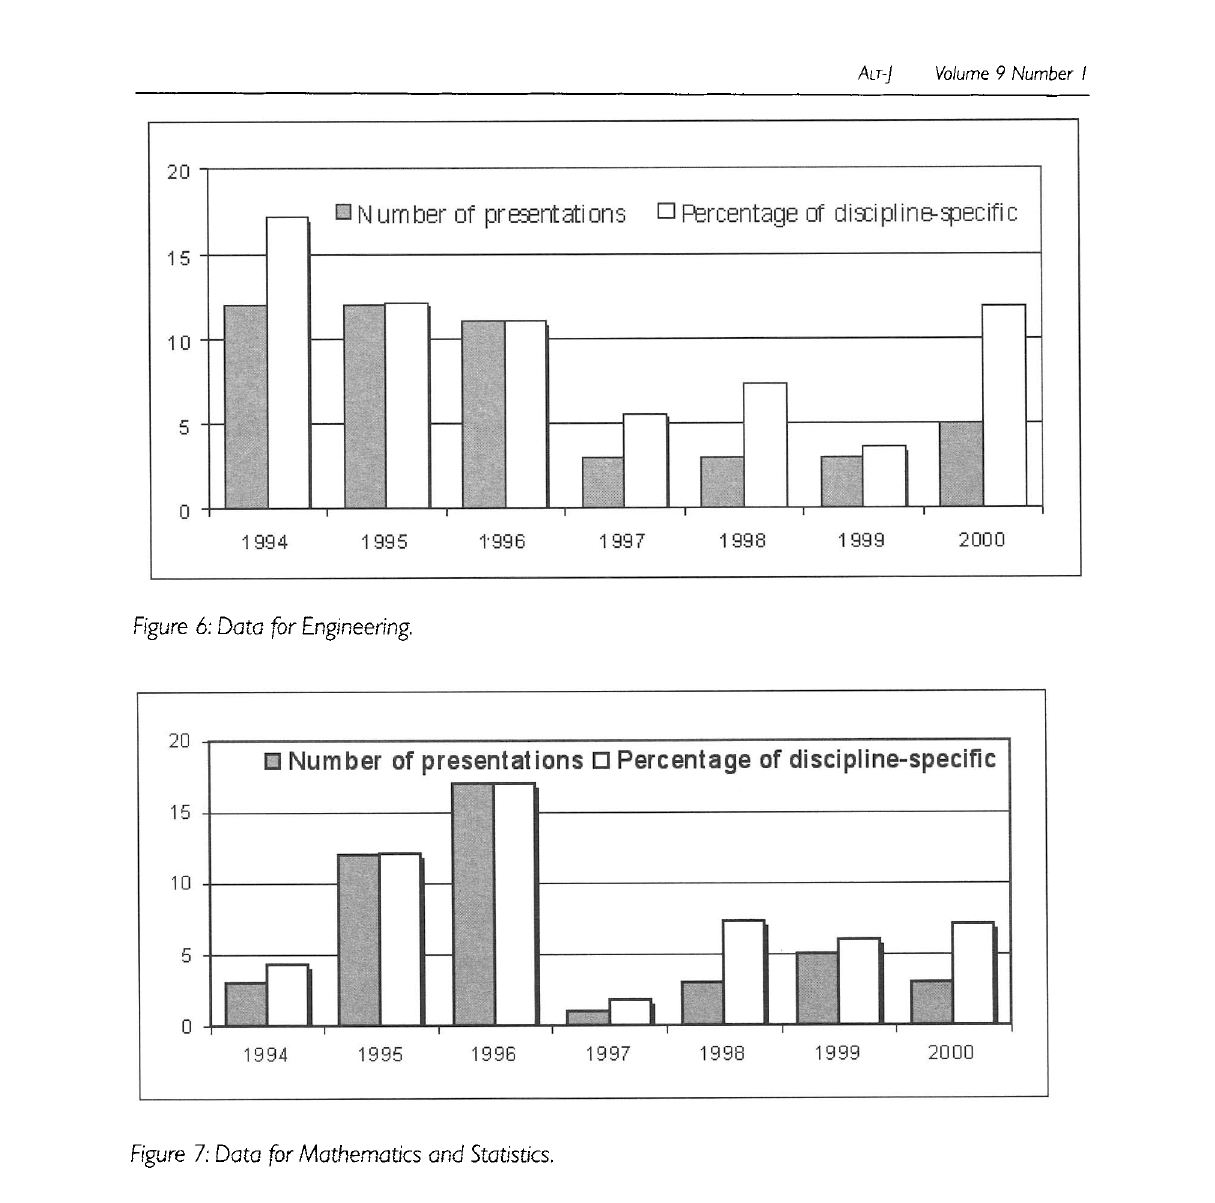
Figure 7: Data for Mathematics and